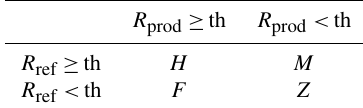
Table 1. Contingency table commonly used for characterizing de- tection errors of precipitation